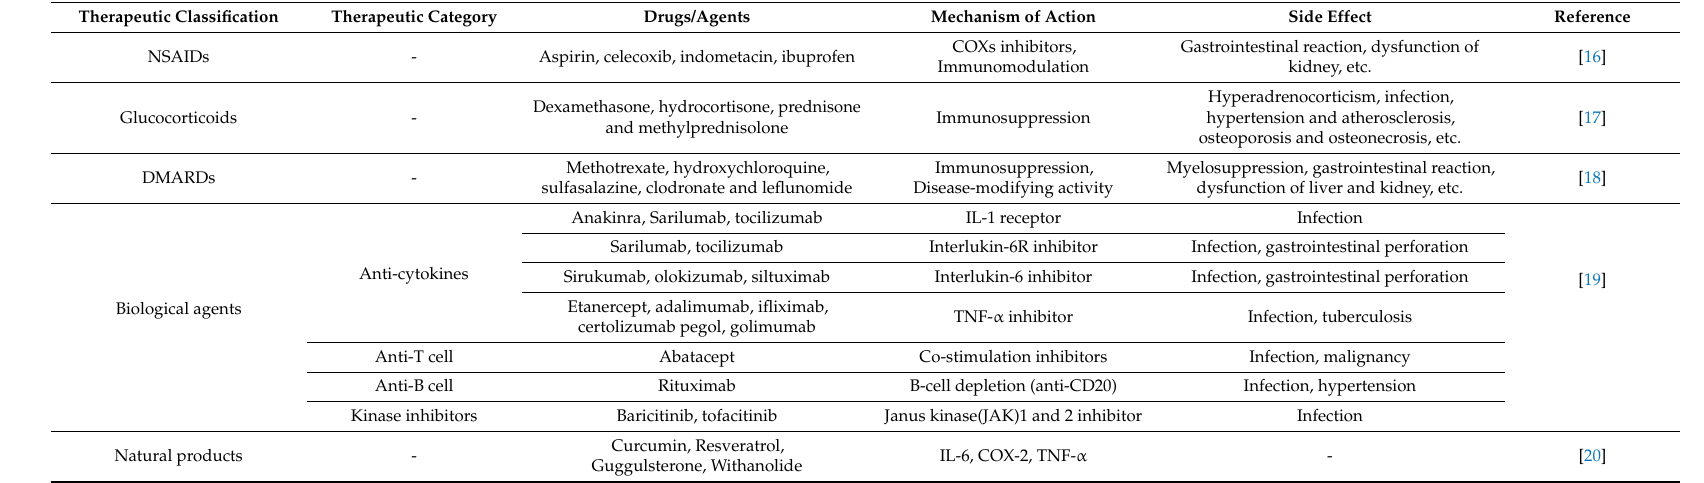
Table 1. Current pharmacotherapies in the treatment of Rheumatoid